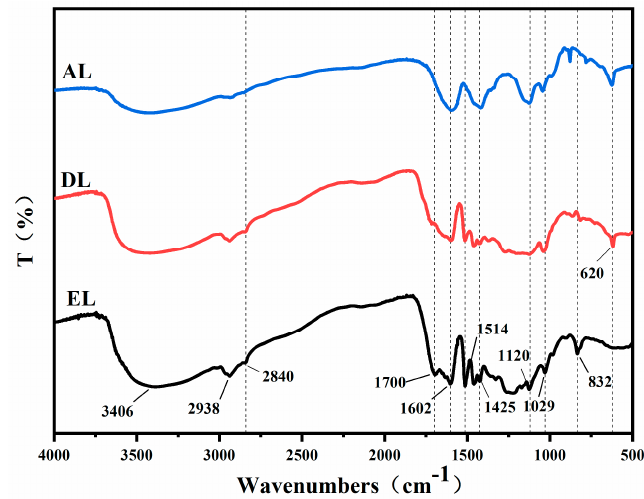
Figure 1. FTIR of different kinds of lignin.